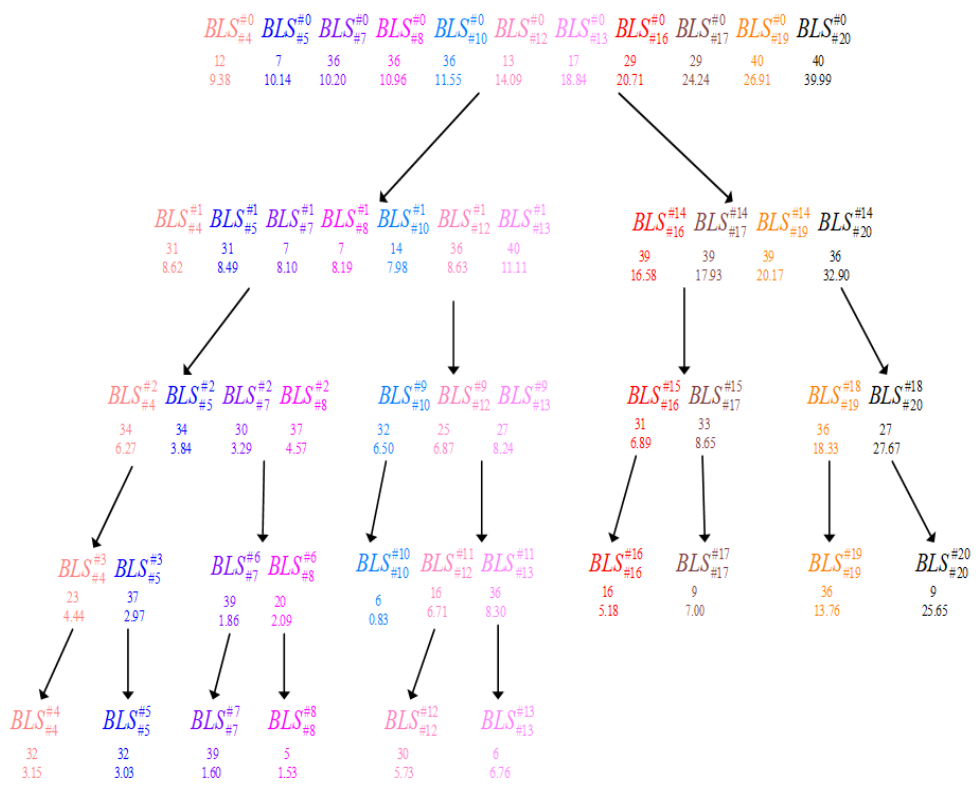
Figure 5. Optimal parameter dendrogram for a BLS model. The # has no special meaning , and #0 represents node 0.